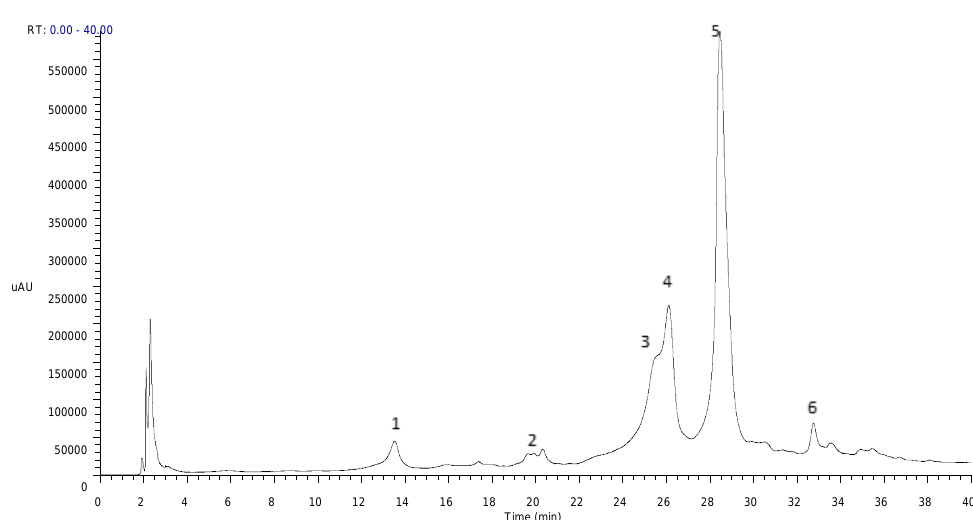
Figure 1. HPLC-PDA-ESI/MS n profile of 70% ethanol extract from Cv recorded at 280 mn. It was used the gradient 2 described in Material and Methods section. (The chromatogram of the extract is not shown up to 40 min as no further compounds were eluted after this time period. Peaks 1–6 identification is showed in Table 5).